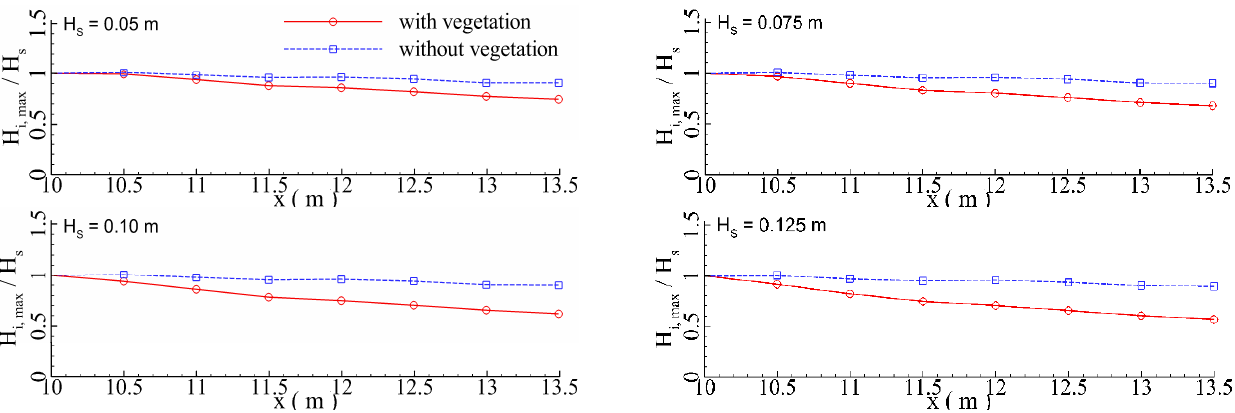
Figure 13. Spatial distributions of local maximum wave height under different significant wave heights.